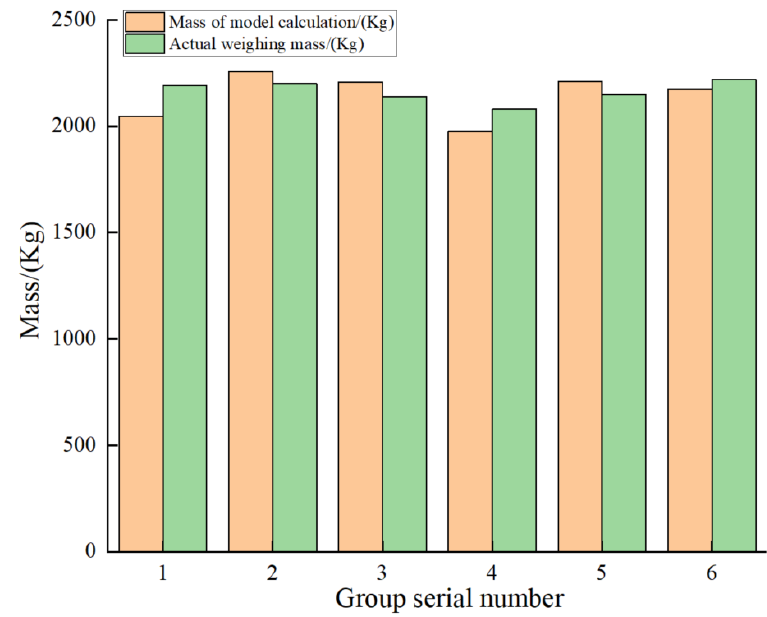
Figure 8. Field harvesting test data.